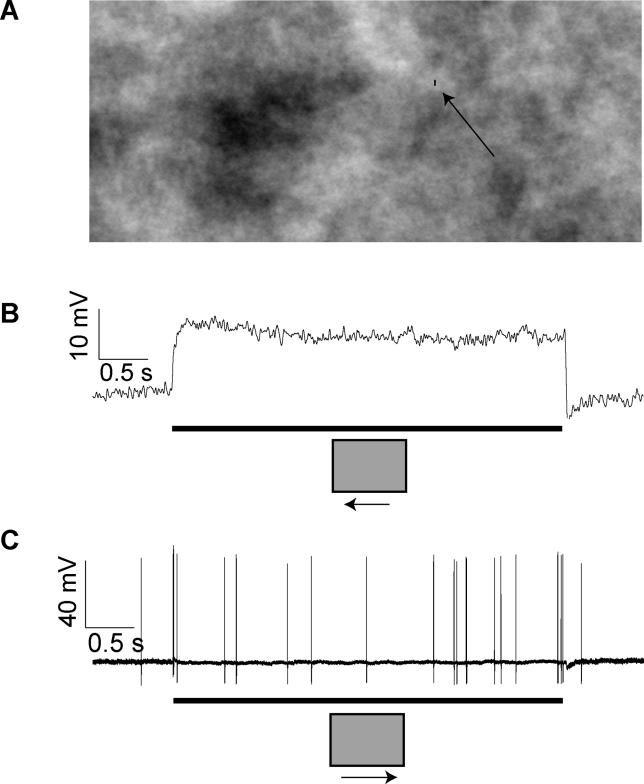
The Background Clutter Pattern Used in Figure–Ground ExperimentsThe pattern used in figure–ground experiments (A) contains components of random frequency and phase, with 1/f statistics similar to those of natural scenes. It excites HS tangential neurons maximally (average of five recordings [B]), but has no effect on most STMDs (STMD 1 [C]). The bars indicate peri-stimulus duration and the arrows the direction of clutter motion.